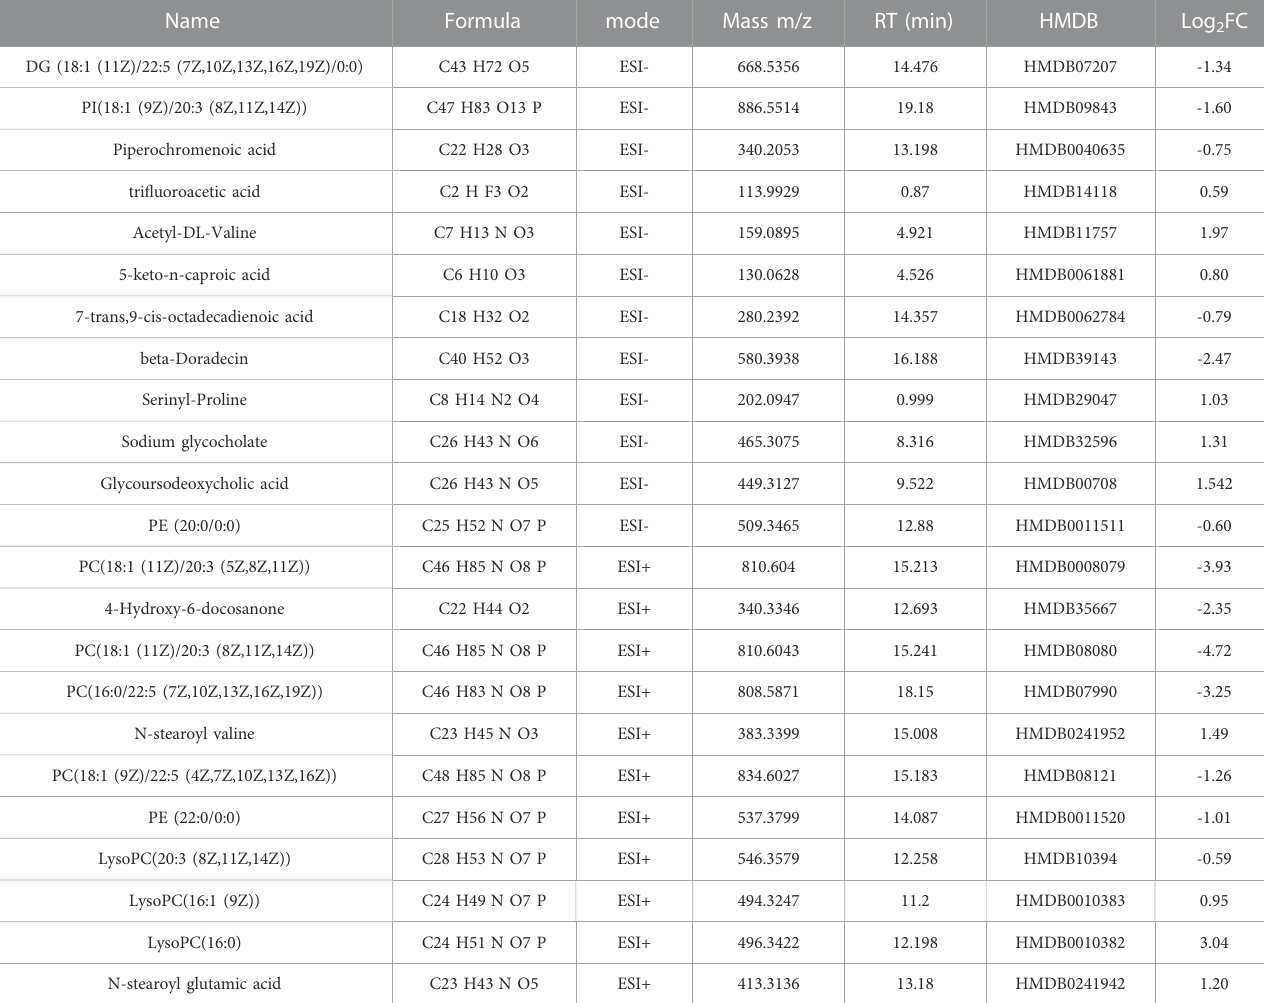
TABLE 3 Differential metabolites in rat plasma associated with chronic heart failure ( p < 0.05).